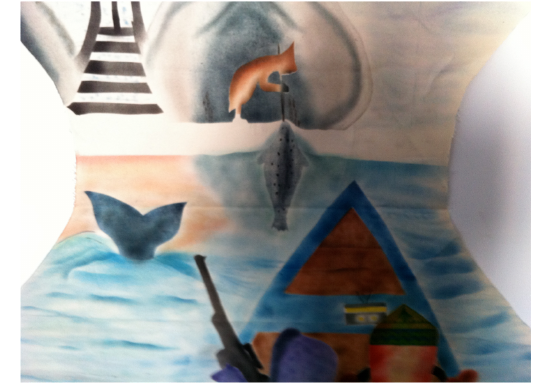
Fig. 4 . A close-up photo of the mural before